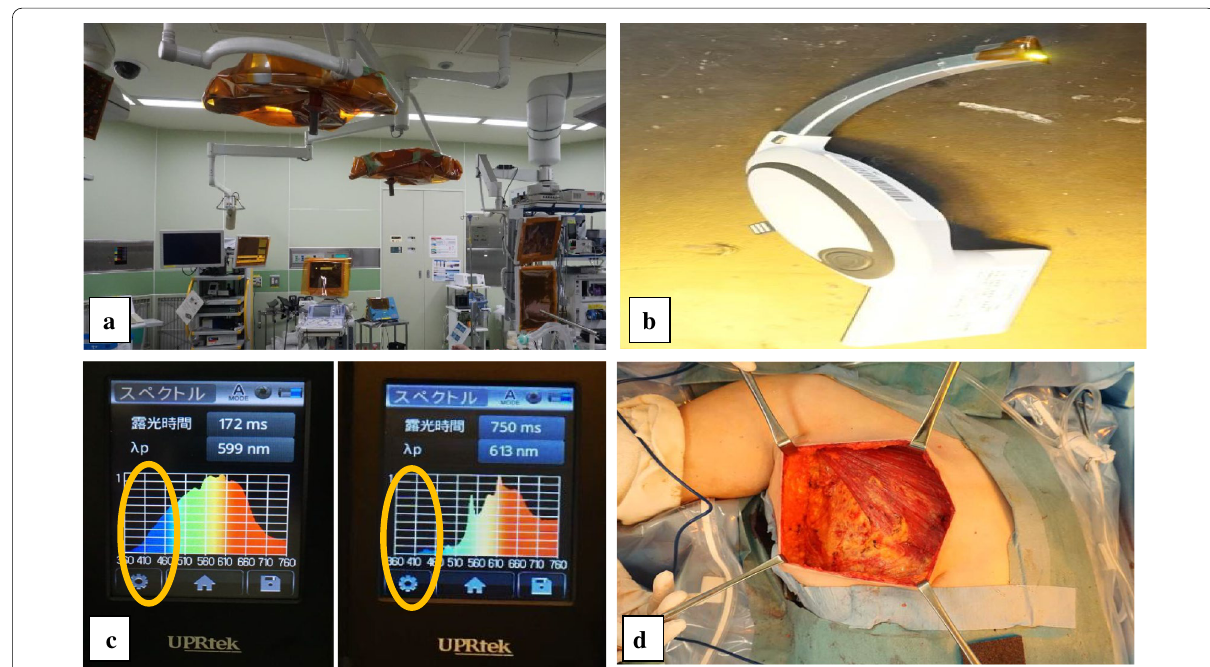
Fig. 2 Modifications to the operating room. a In the operating room, several emitters are covered with the special film. The light intensity of the ceiling light did not change the 400 nm region of the light wavelength measured on the surgical table, so for the convenience of the surgery, the ceiling light was not filtered. b The laryngoscope’s light is also covered with the film. c We measured the lights at the operation table. We confirmed that the film completely blocked light with a wavelength of 400 nm. (Left) without the film, (right) with film attached (yellow circle). d We could safely manage the operation in a sufficiently bright